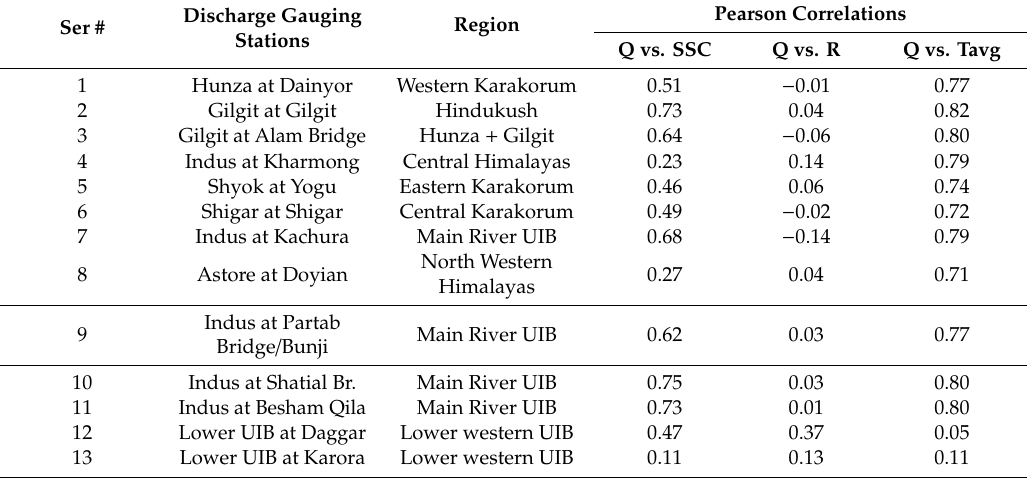
Table 10. Pearson’s correlations between daily flows, SSC and gridded climatic datasets since 1981–2010 in the Upper Indus Basin